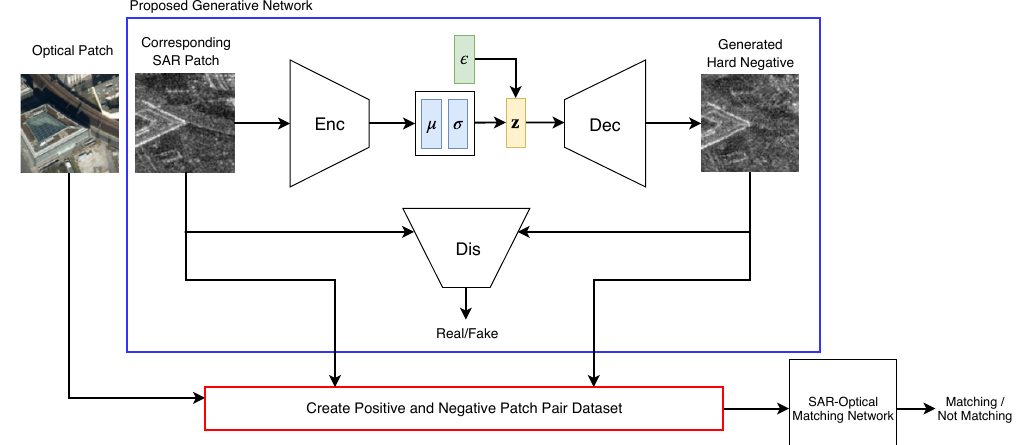
Figure 2. The proposed generative hard-negative mining framework. The GAN is trained to create hard-negative samples based on the input image patch. Together with the original corresponding optical patch, these samples are then used to train the SAR-optical matching